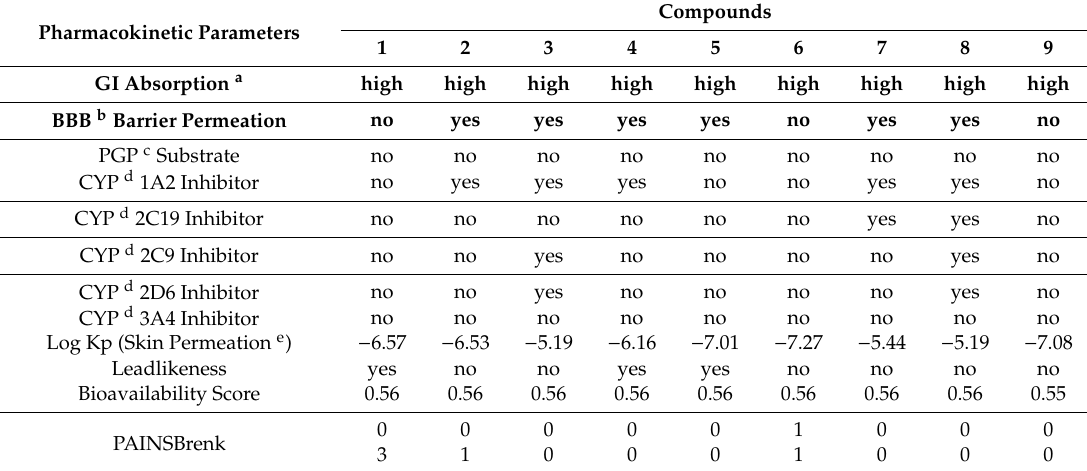
Table 2. Pharmacokinetic and medicinal chemistry parameters of compounds 1–9.